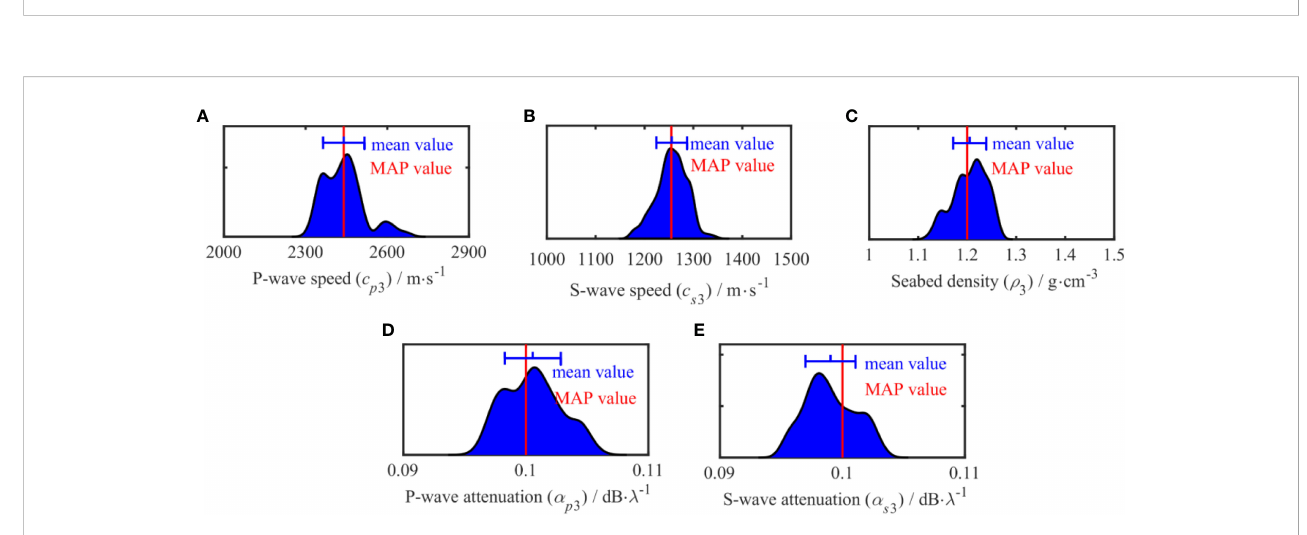
FIGURE 14 One-dimensional marginal probability distribution of semi-in fi nite